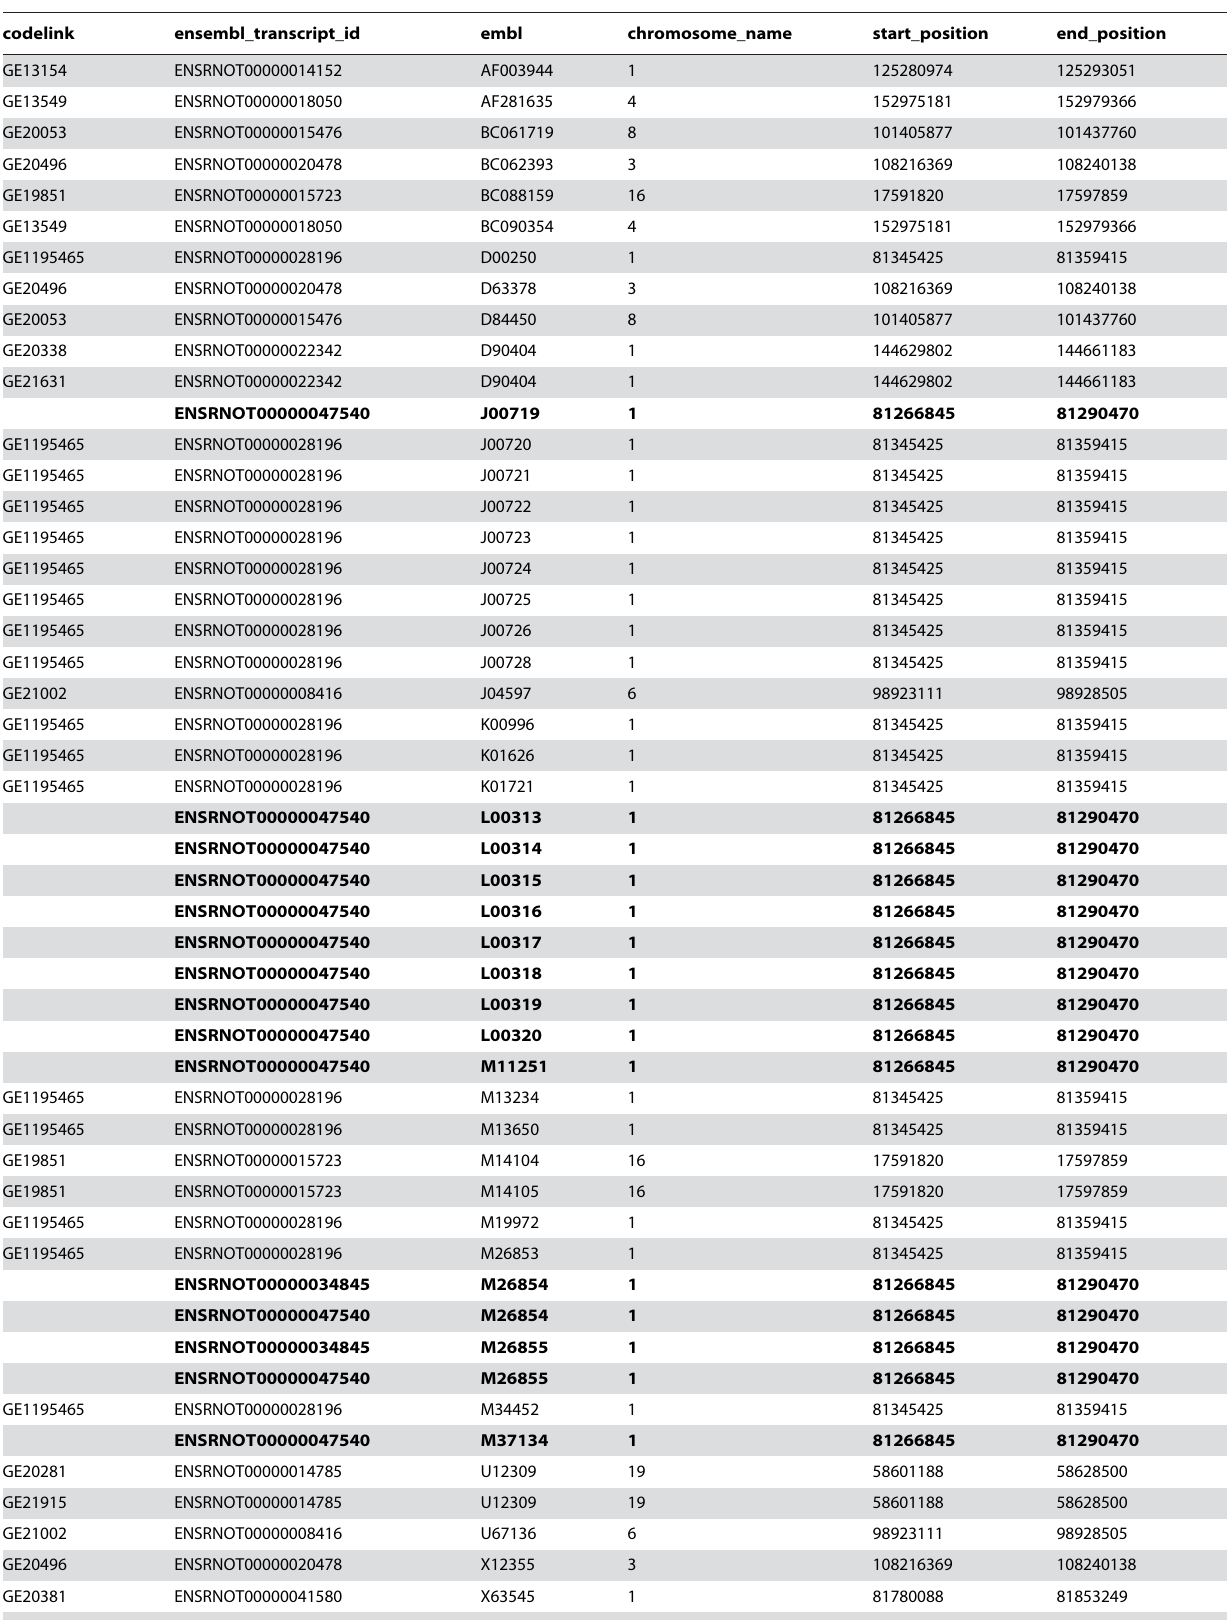
Table 2. R output (using biomaRt library) providing CodeLink bioarray IDs and their mappings to Ensembl transcripts ( chr: start- end position ), as explained in the